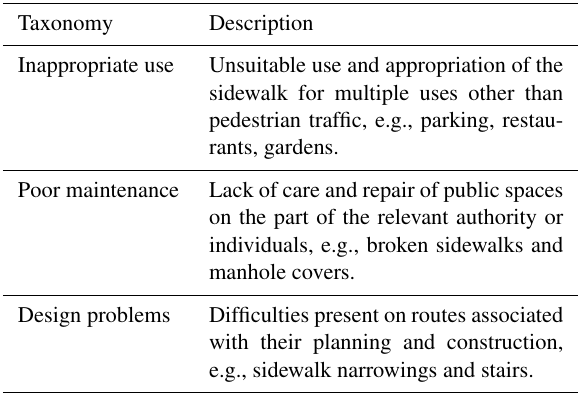
Table 1. Classification based on micro-vulnerability origin (modi- fied from León and March,